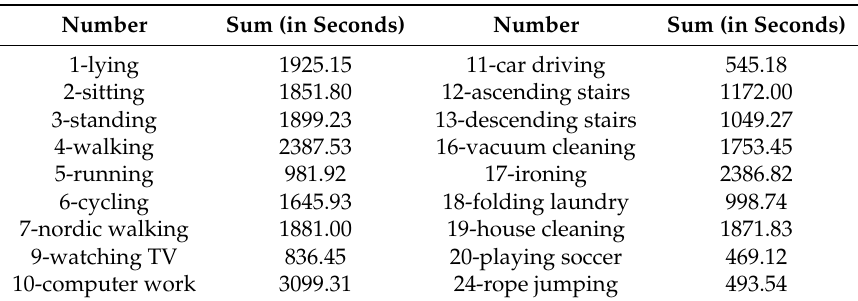
Table 1. Activities performed by subjects.